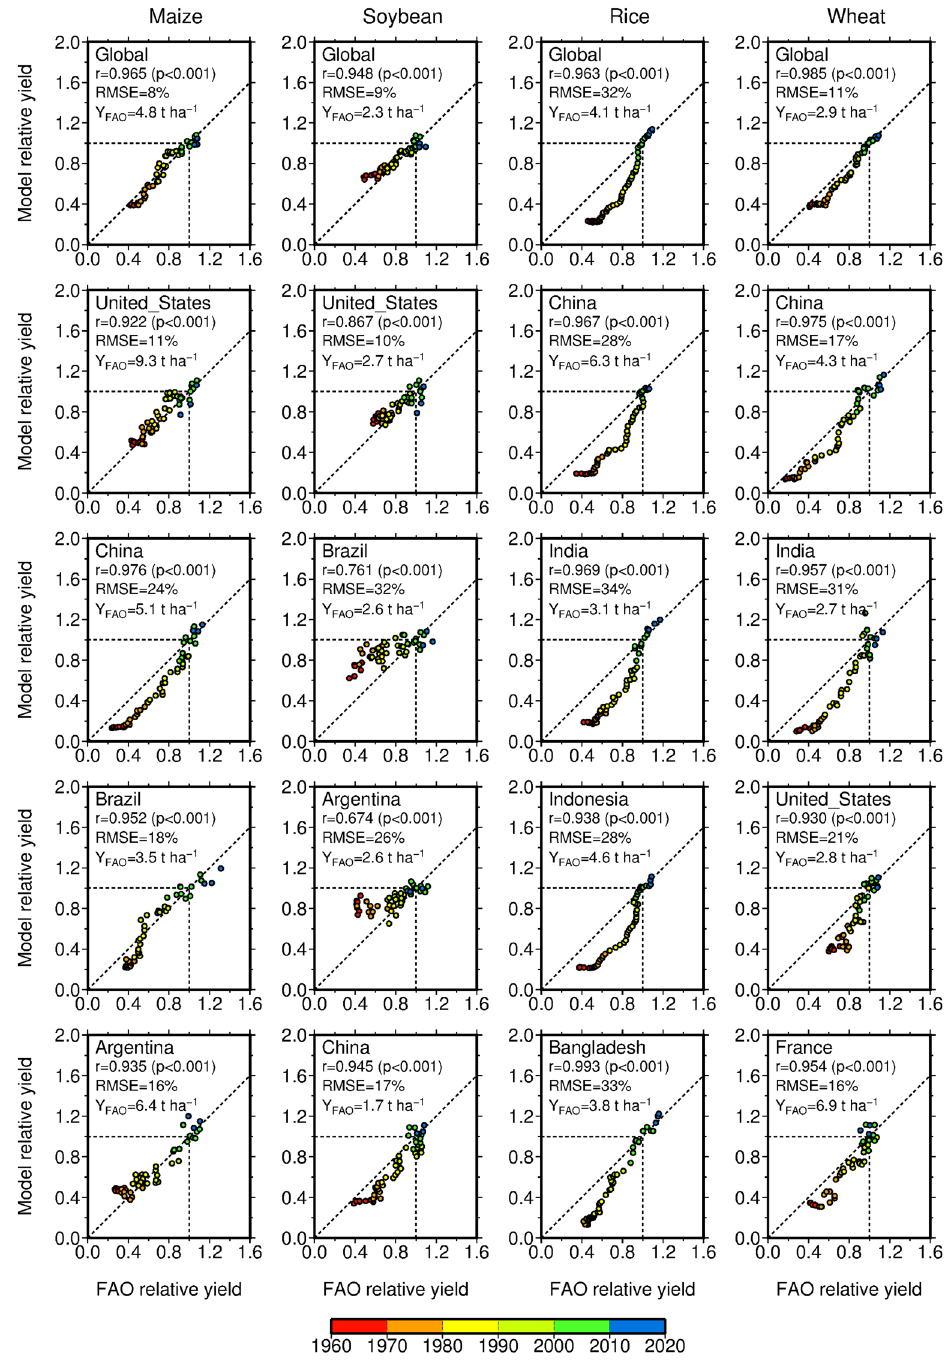
Figure 1. Comparisons of the 2-year running global and country mean yields of four crops for 1961–2012 between the modeled and FAO-reported data. The modeled and reported data were scaled separately to render the mean yield for 2001–2010 equal to one. The correlation (r), p-value (p), root-mean-squared error (RMSE) as a percentage of the mean reported relative yield for 1961–2012, and the mean reported absolute yield for 2001–2010 (Y FAO ) are also presented. See Post-processing for the crop model output in Supplementary Note for more